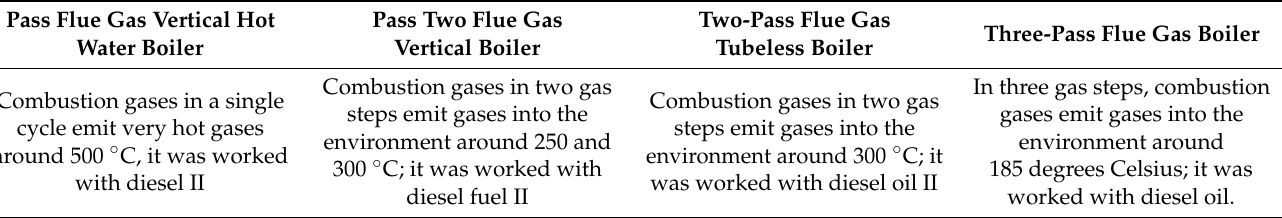
Figure 3. Vertical, tubeless boiler with two flue gas paths. Two-pass boiler without tubes. The first route is the passage of gases through the combustion chamber; the gases descend to the bottom and surround the water chamber and rise vertically to exit through the chimney. Table 1. Comparison of the different boilers.